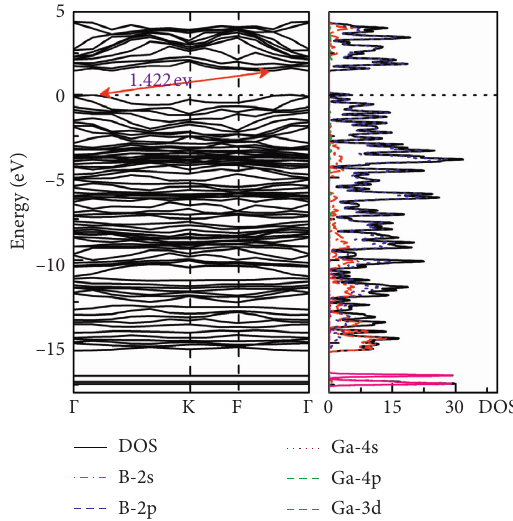
Figure 4: Electronic structure of Ga doped borophene.